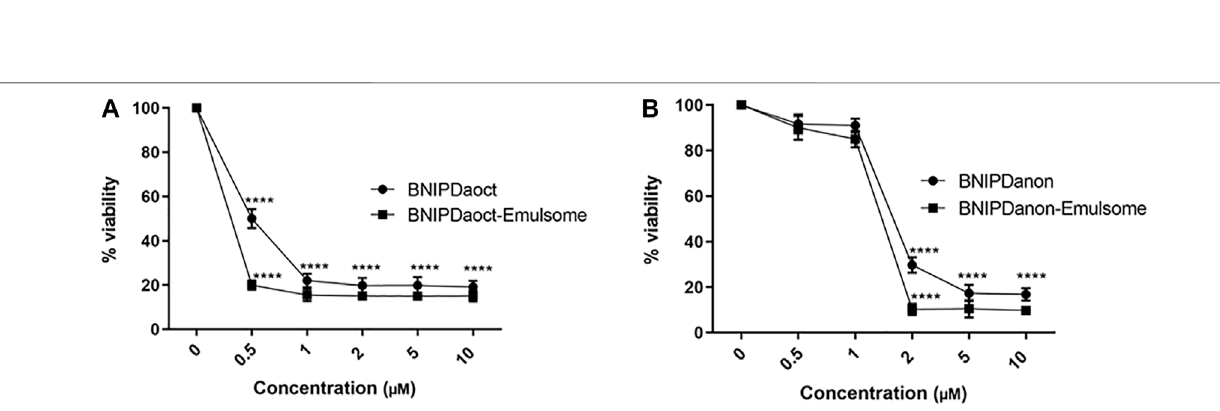
Frontiers in Nanotechnology |